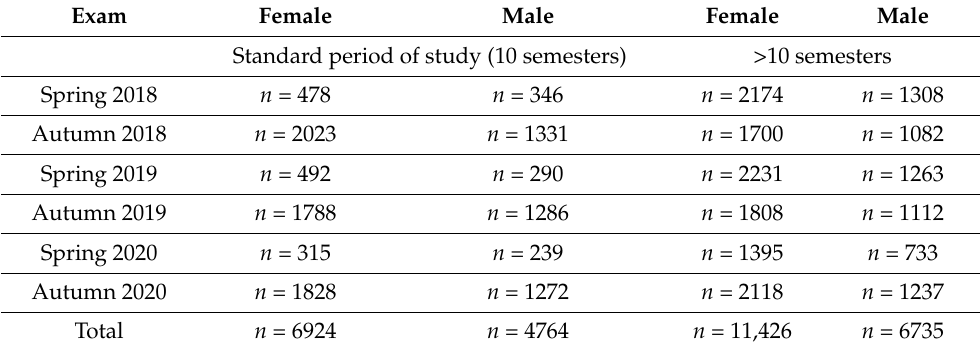
Table 2. Distribution of exam participants by gender and designated period of